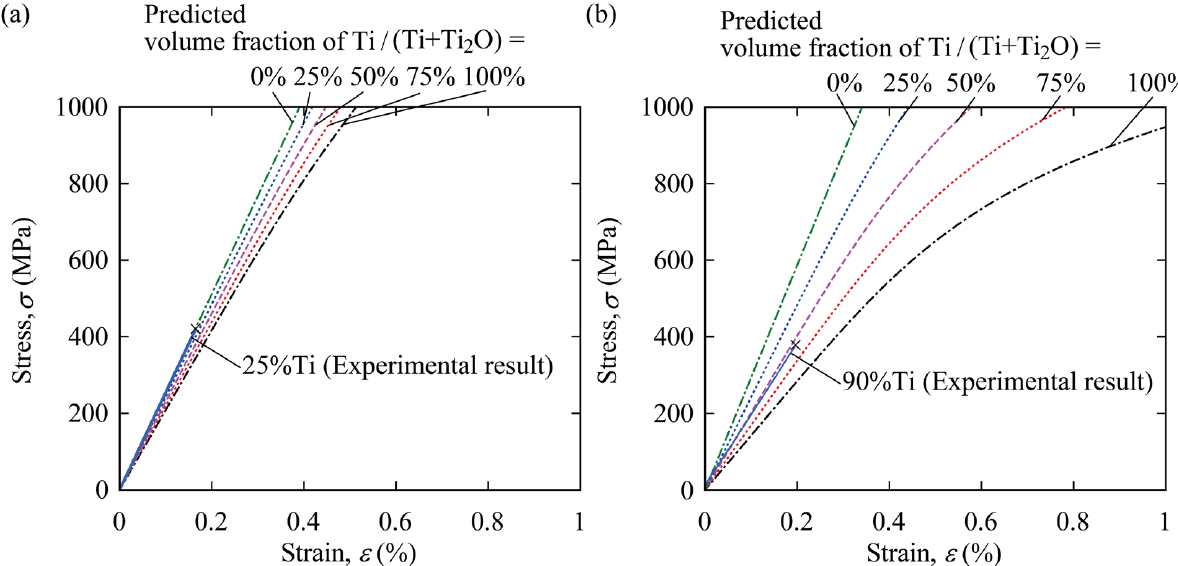
Figure 12. Comparison of estimated stress–strain curves of the PSZ-Ti composites with the experi- mental results. ( a ) Volume fraction of Ti and Ti 2 O of 25%; ( b ) volume fraction of Ti and Ti 2 O of 90%. The experimental data are the same data shown in Figure 1a.